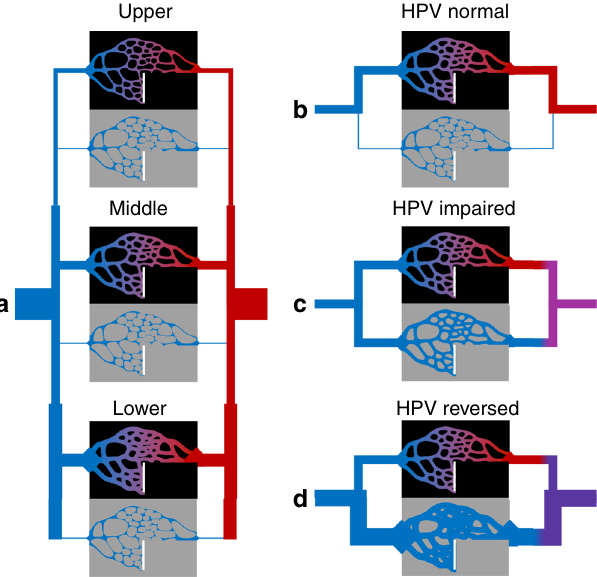
Fig. 1 Model overview. a Schematic of the 12-compartment model used to simulate distributed perfusion in aerated and injured compartments at different height levels. Deoxygenated mixed venous blood (blue) passes through aerated (black) or injured (gray) compartments, and returns to the oxygenated mixed arterial blood (red). Vascular resistance in each compartment was determined by height level, presence of perfusion defect or pulmonary embolism (white bars), as well as the degree of oxygenation or injury. Hypoxic pulmonary vasoconstriction (HPV) could be either b “ normal ” with reduced perfusion to regions of low end-capillary oxygen content, c “ impaired ” with no response, or d “ reversed ” with increased perfusion to injured